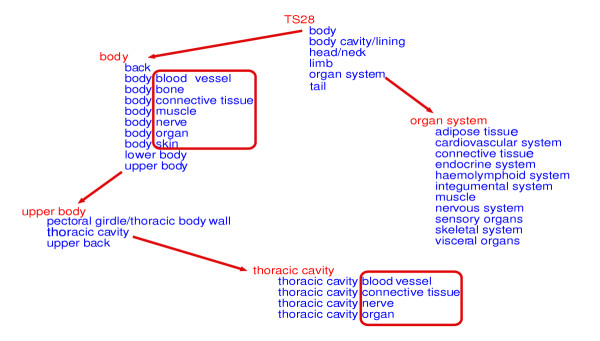
Hierarchical organization of the adult mouse anatomy ontology. The hierarchy is divided into spatial and organ system components. Blocks indicate generic group terms appropriate to multiple spatial regions.